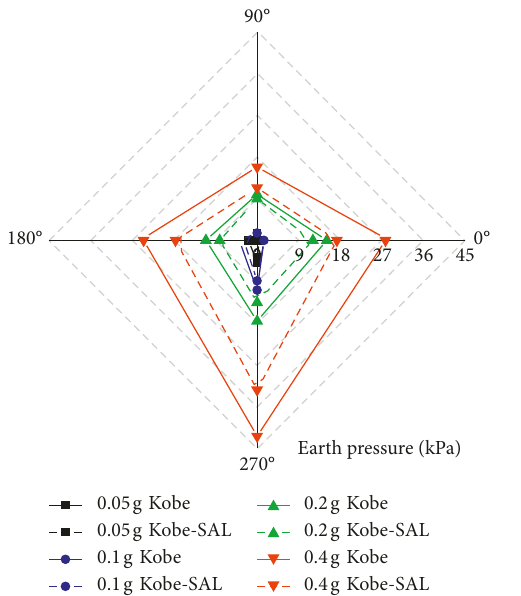
Figure 21: Comparison of maximum earth pressure with the SAL.